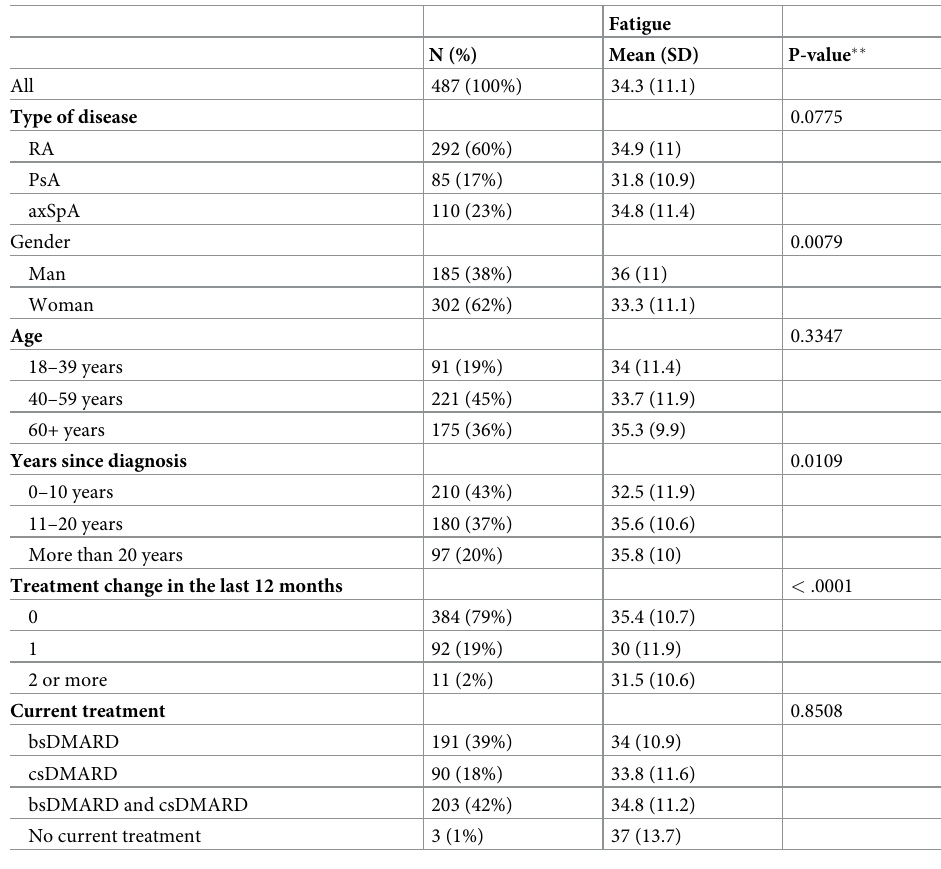
Table 1. Characteristics of the study population and mean scores of fatigue measured by FACIT-Fatigue �